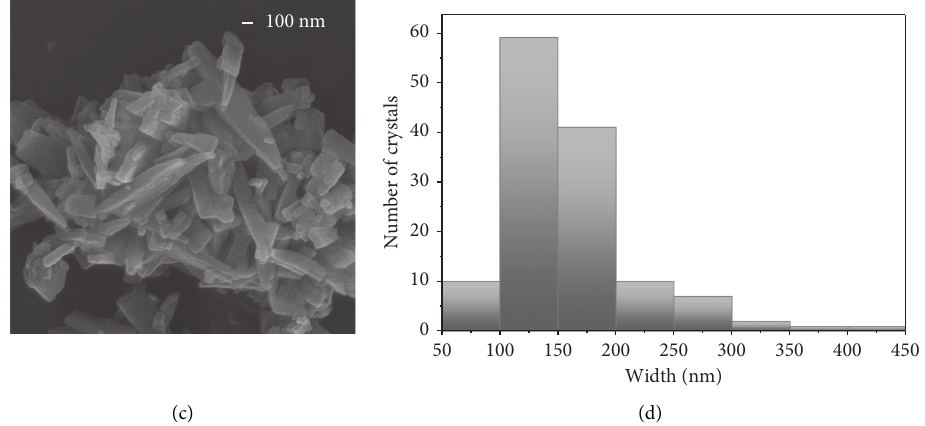
Figure 3: SEM images of compound 1 (a) and 1n (c) together with statistical histograms of widths (b, d).